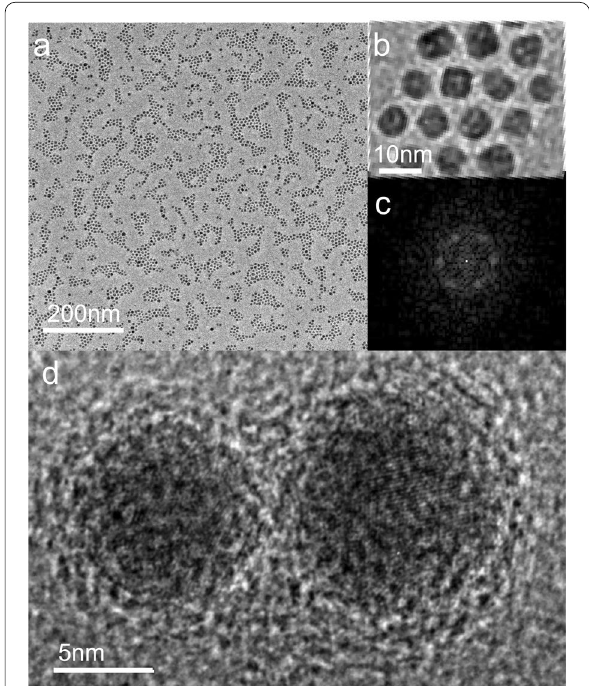
Fig. 2 a Low-magnification TEM image of Fe nanoparticle arrays deposited on a TEM grid covered by amorphous carbon film, with a deposition rate of 0.1 Å s − 1 . Domains of close-packed 2D monolayers with long orders can be identified. b High-magnification TEM image of an ordered densely packed 2D superlattice of Fe nanoparticles. c FFT corresponding to nanoparticle arrays in ( a ). d HTREM image shows lattice images of individual Fe